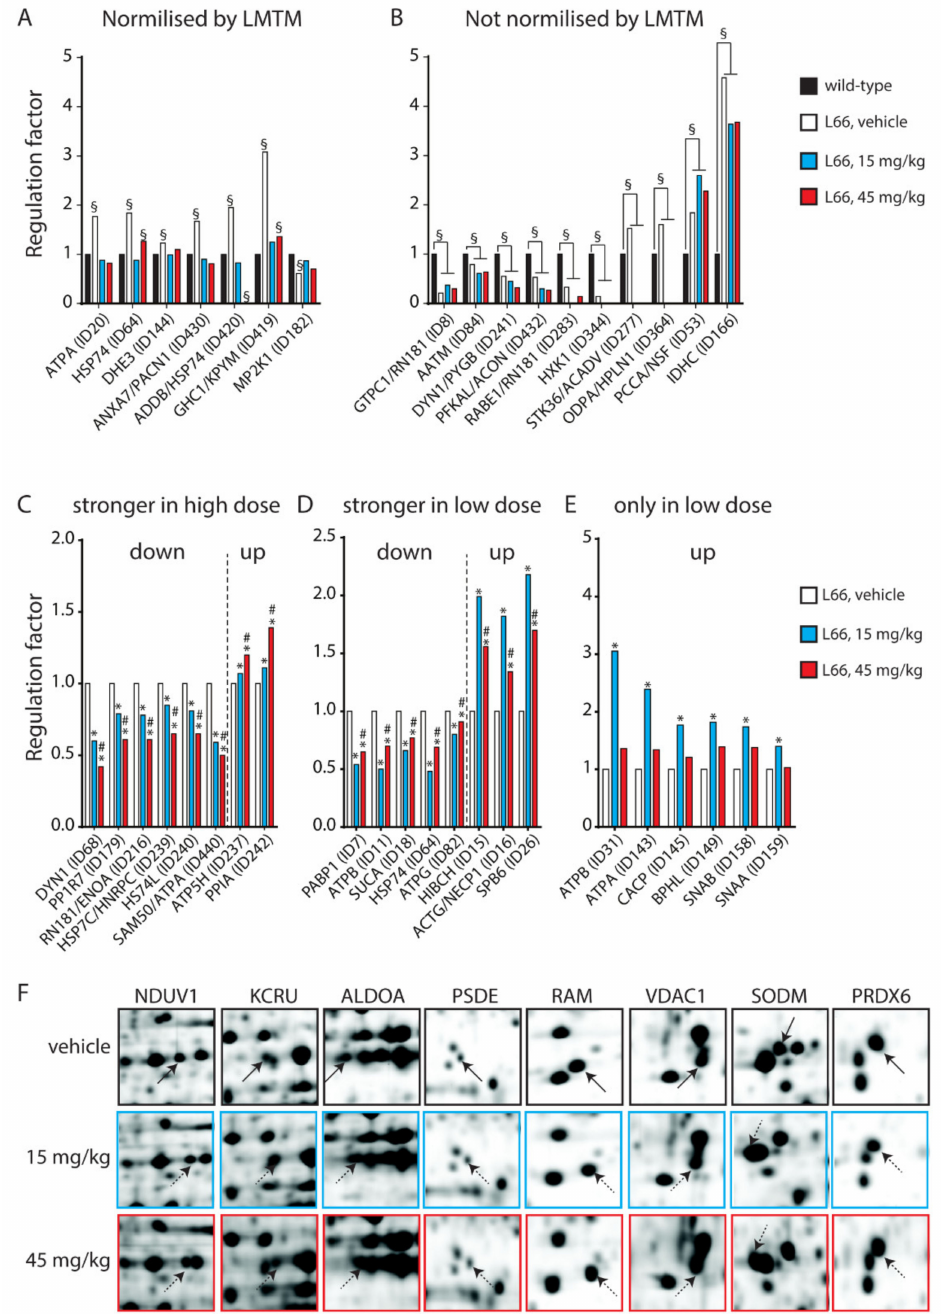
Figure 5. Protein species with LMTM dose-dependent regulation. ( A , B ) Twenty-seven protein species (17 spots) were common between experiments 1 and 2. ( A ) Ten of these protein species (7 spots) were normalised by LMTM, ( B ) while no clear effect was identified for the remaining (17 species in 10 spots). ( C – E ) Twenty-six protein species (22 spots) were dose-dependently regulated with ( C ) stronger effect at higher dose (9 protein species downregulated and 2 upregulated), ( D ) stronger effect at lower dose (5 protein species downregulated and 4 upregulated), ( E ) only 15mg/kg was effective (6 protein species upregulated). ( F ) Eight further protein species were regulated at the functional level as they shifted horizontally following LMTM treatment, implying post-translational modifications. §: p < 0.05 vs. wild-type, *: p < 0.05 vs. L66-vehicle, #: p < 0.05 vs.